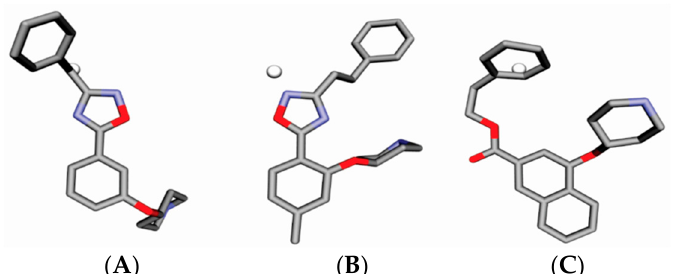
Figure 5. Representation of GCOD-3 (0, − 5, − 1, any) (white sphere) and ( A ) compound 30 , ( B ) compound 42 , and ( C ) compound 60 . CODs occupancy represented by white spheres contributes to increasing the potency of compounds. The gray and red representations are carbons and oxygen atoms.